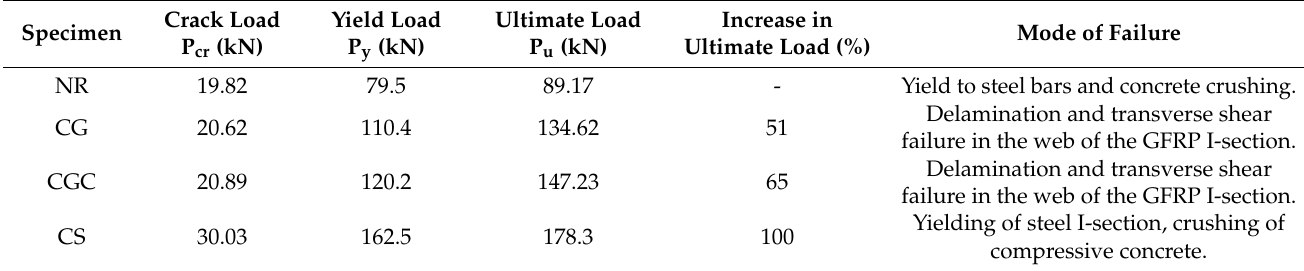
Table 5. Summary of the experimental results under static